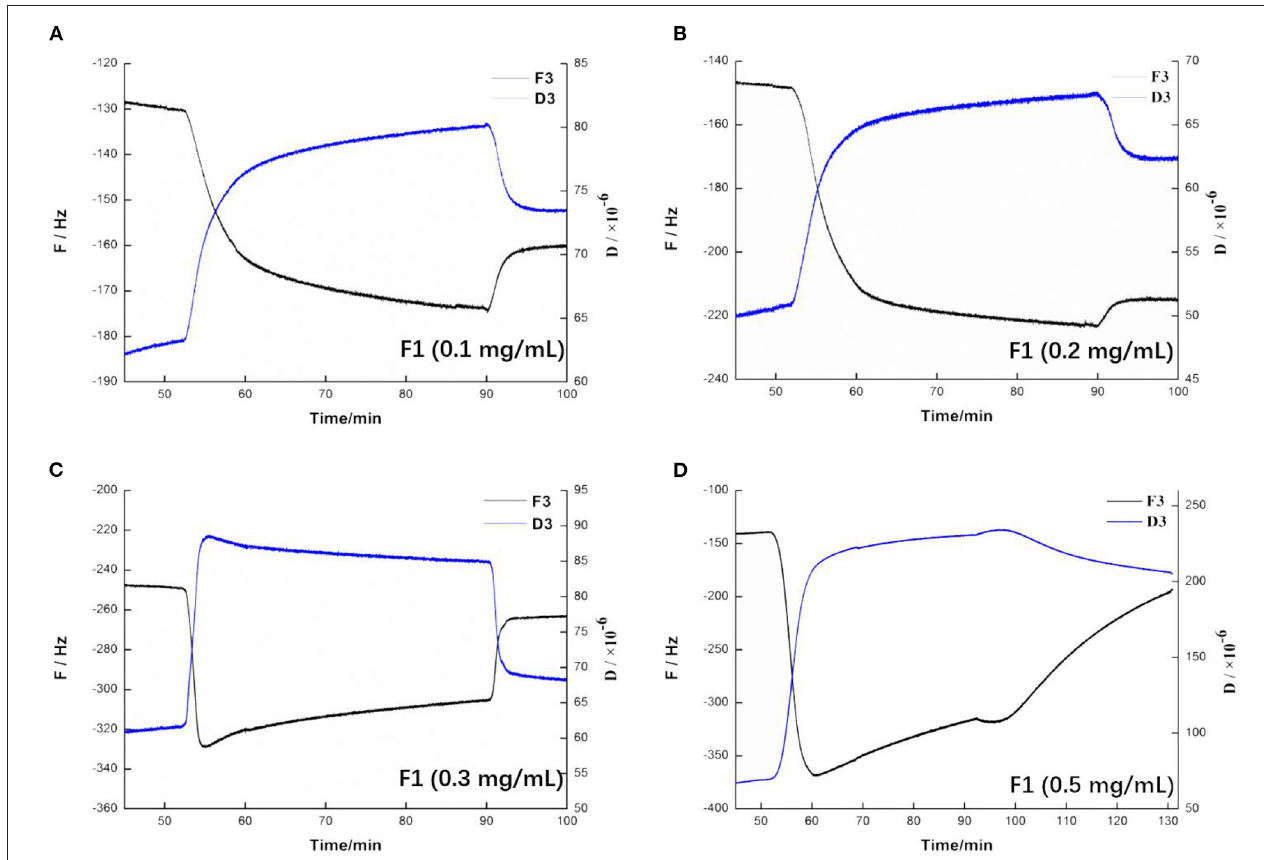
FIGURE 6 | Changing trend of frequency and dissipation at three times the frequency on the membrane after applying antimicrobial peptide F1. Different concentrations of antimicrobial peptide F1: (A) 0.1 mg/mL, (B) 0.2 mg/mL, (C) 0.3 mg/mL, and (D) 0.5 mg/mL.